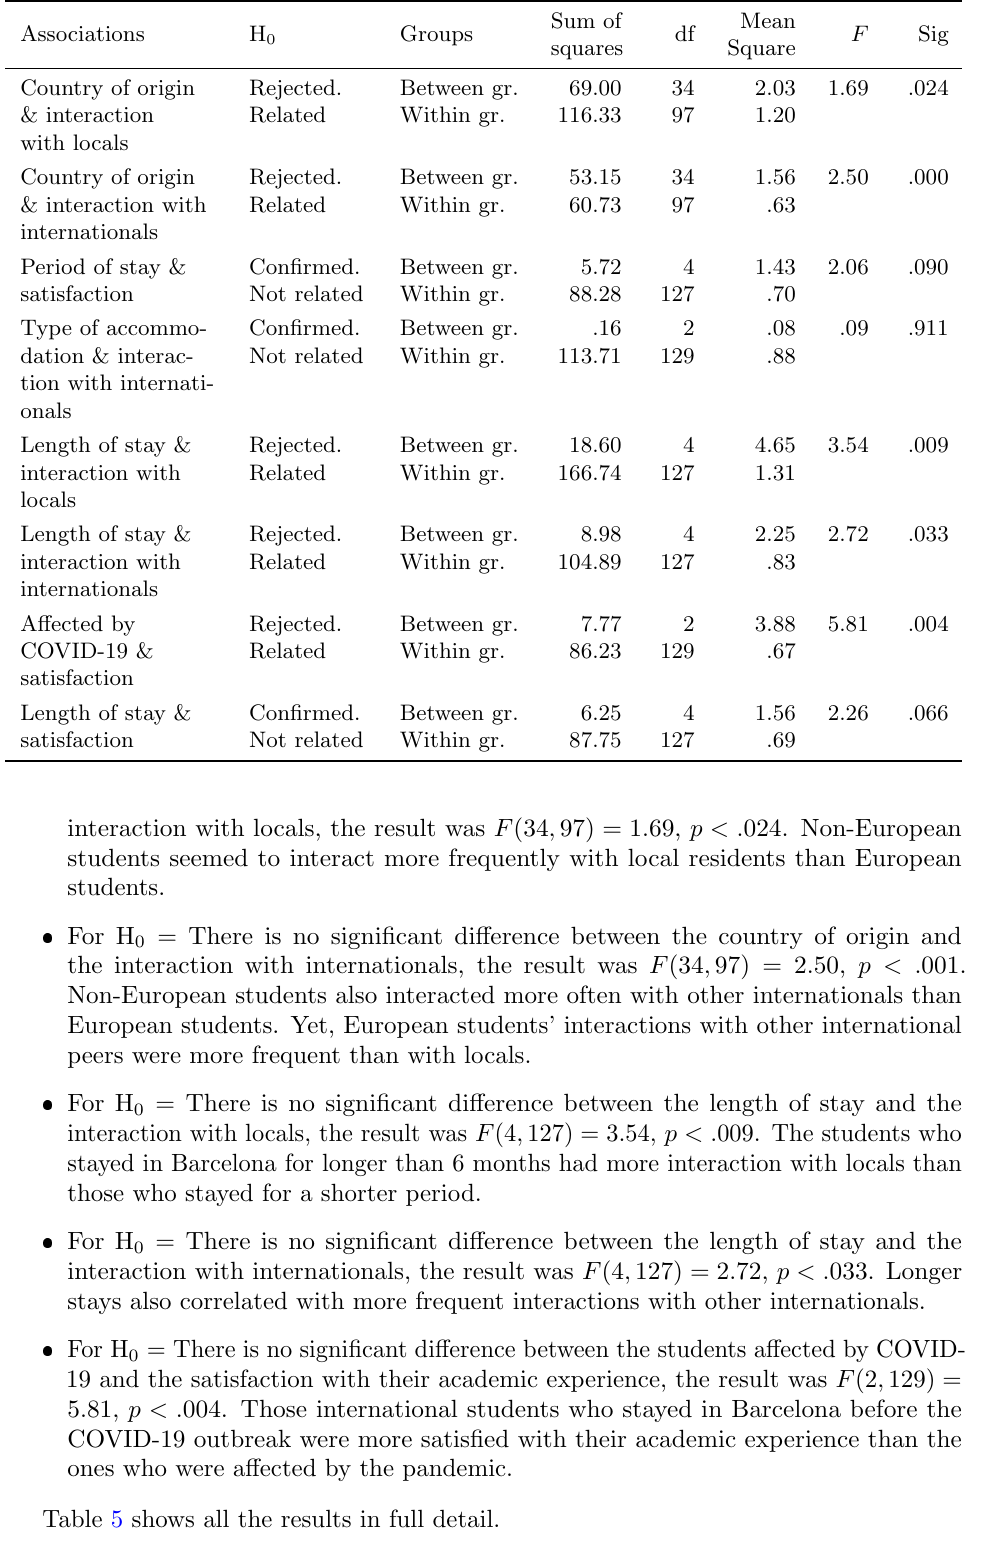
Table 5: ANOVA test